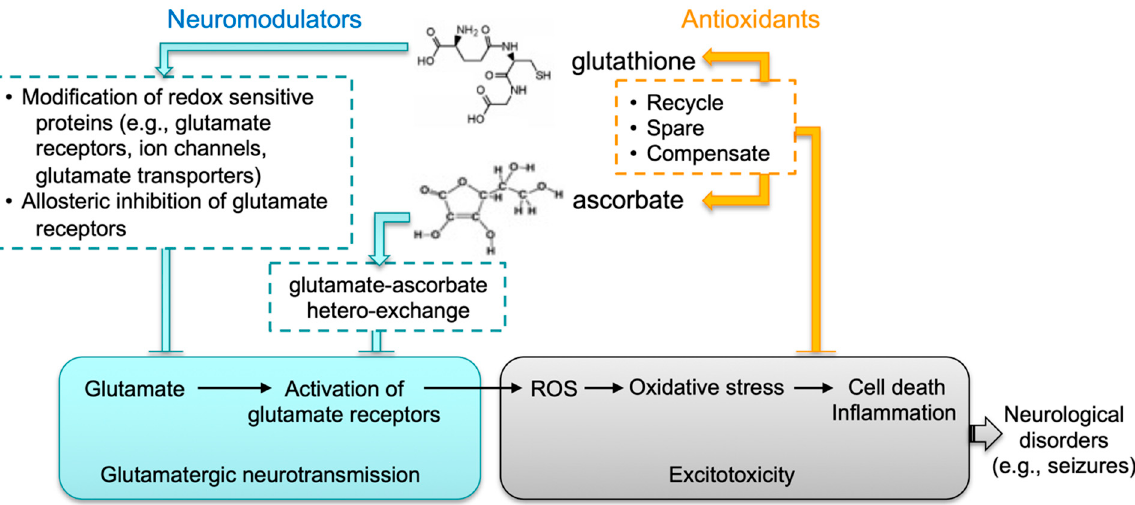
Figure 6. Proposed functional crosstalk between GSH and AA in glutamatergic neurotransmission. functions: (1) Both molecules likely act as neuromodulators that coordinately control excitatory glutamatergic neurotransmission. GSH may modulate synaptic transmission and plasticity via redox- sensitive proteins, including glutamate receptors, calcium channels, and glutamate transporters.